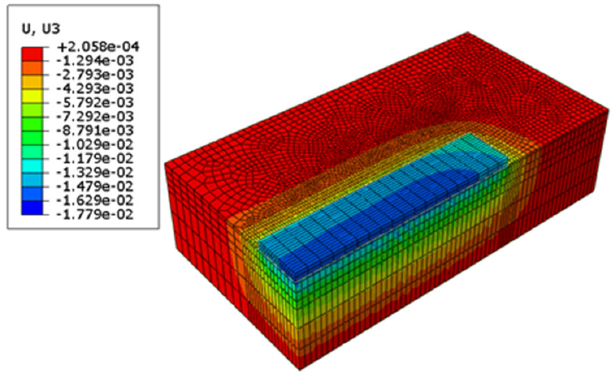
Figure 15. Vertical settlement contour of rigid pile composite foundation (m).